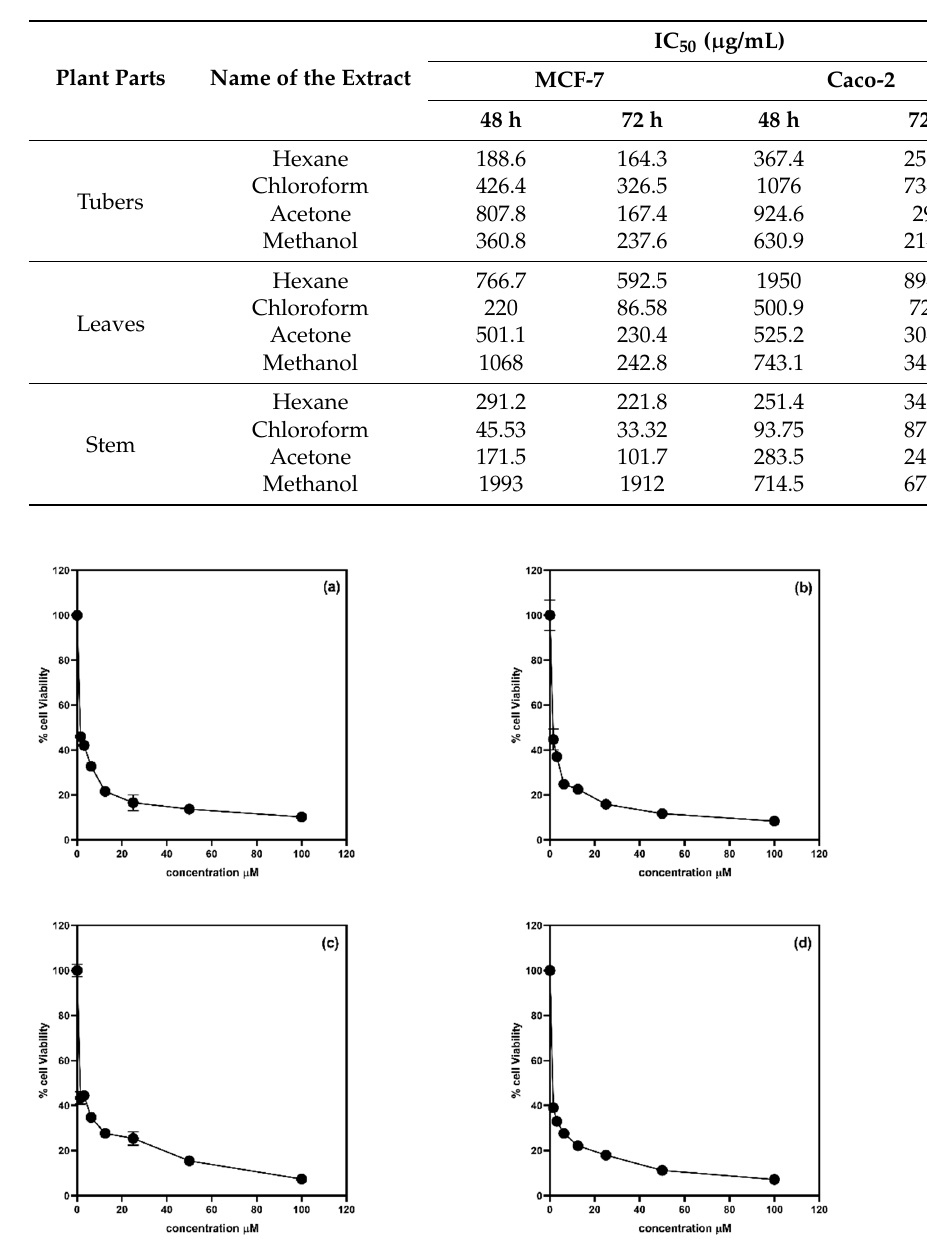
Table 2. Cytotoxic activity of different solvent extracts of tuber, leaves and stem of M. Peregrina on MCF-7 and Caco-2 cancer cell lines.